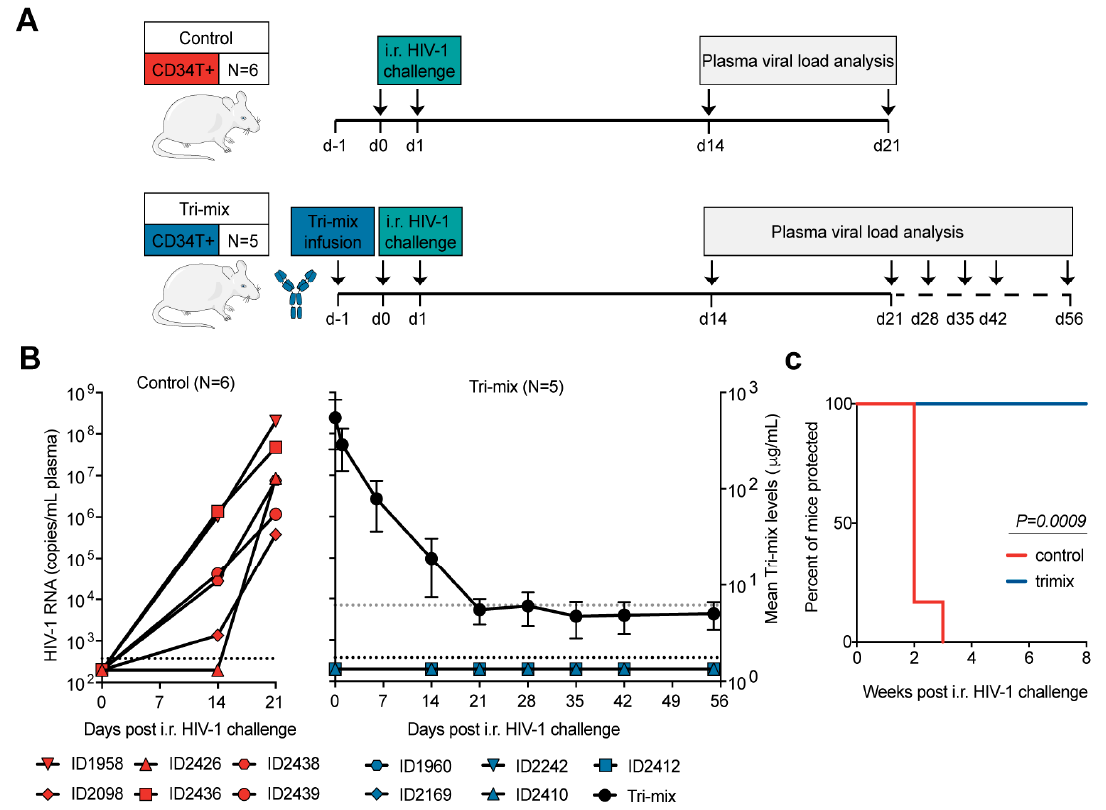
Figure 4. Antibody-mediated prevention of mucosal HIV-1 infection in CD34T+ mice. ( A ) Schematic representation of the experimental design. CD34T+ control mice were given high dose i.r. challenges with NL4-3 YU2 HIV-1 on consecutive days, whereas, the CD34T+ tri-mix mice additionally received i.p. injection of 2 mg each of 3BNC117, 10-1074 and SF12 one day before the 1st HIV-1 challenge. ( B ) Plasma HIV-1 RNA levels over time in the control and tri-mix mice. The lower black dotted line represents the assay quantification limit of 384 HIV-1 RNA copies/mL plasma. The right Y -axis for the tri-mix mice shows mean (N= 5) neutralizing antibody tri-mix levels in plasma over time. The upper grey dotted line represents the limit of detection of the antibody measurement assay. ( C ) Kaplan-Meier curve depicting rate of protection from mucosal HIV-1 infection in control and tri-mix mice from ( B ) statistical analysis done with Log-rank (Mantel-Cox) test. i.r. intra-rectal.